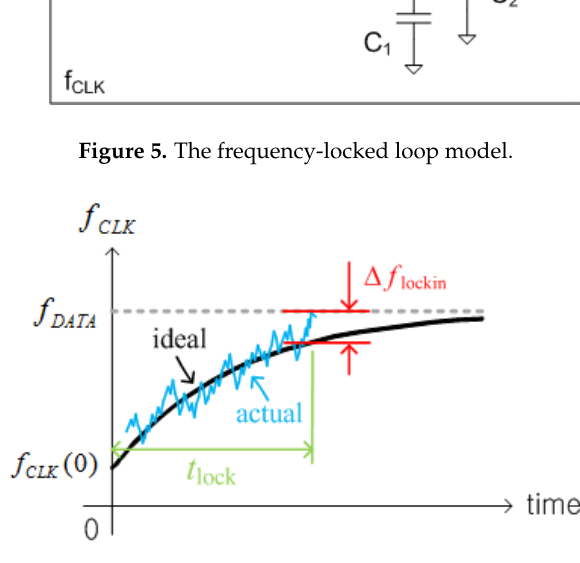
Figure 6. The locking trajectory of f CLK and the lock-in range.